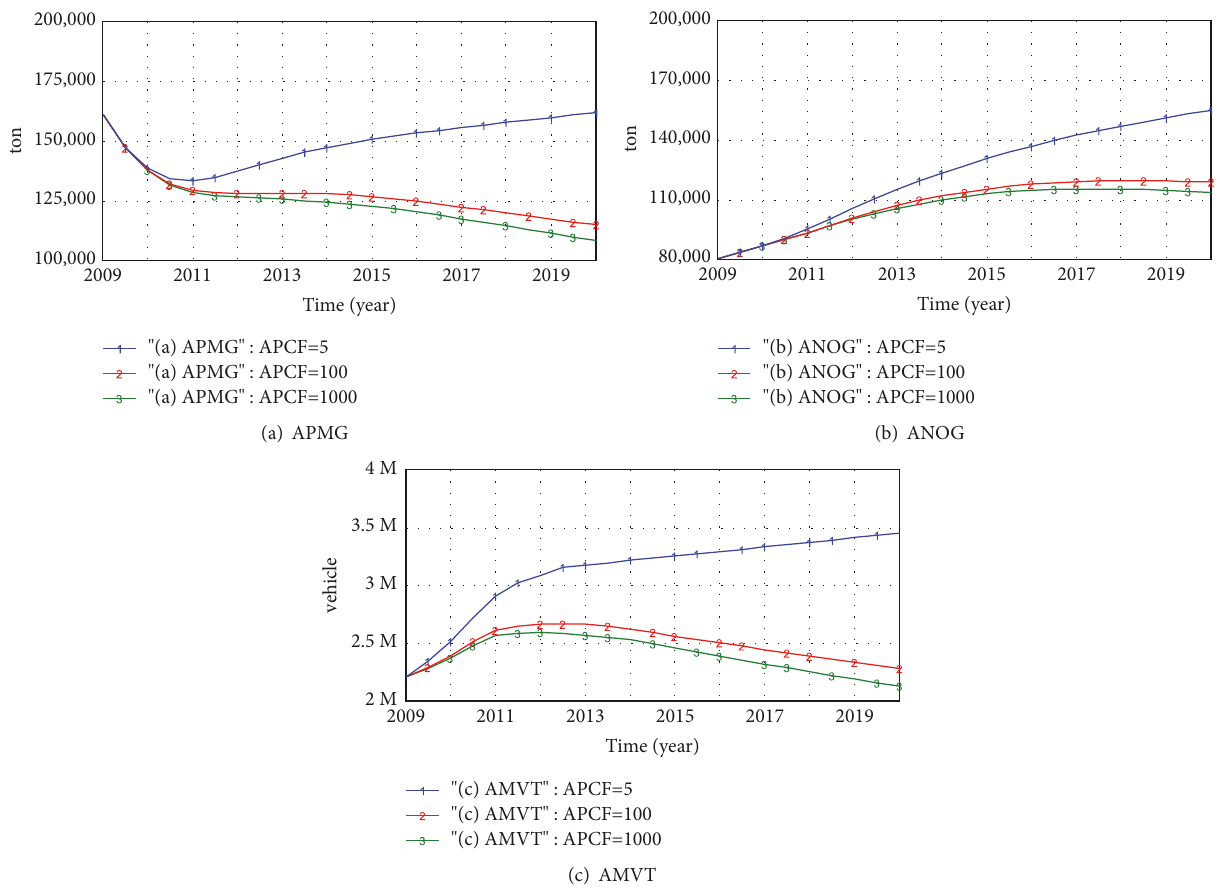
Figure 3: Extreme condition test. (a) APMG. (b) ANOG. (c)